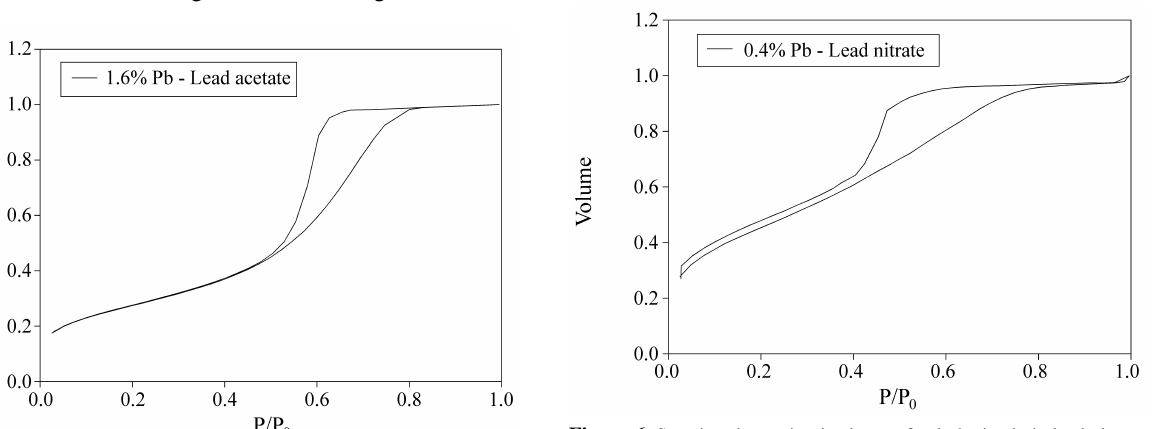
Figure 6. Sorption-desorption isotherm of gel obtained via lead nitrate, heat treated at 900 °C (the weight of the sample was not considered, then volume scale is relative).